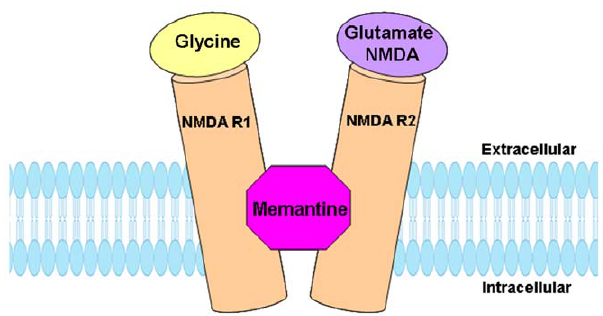
Figure 1. Schematic representation of memantine and NMDA